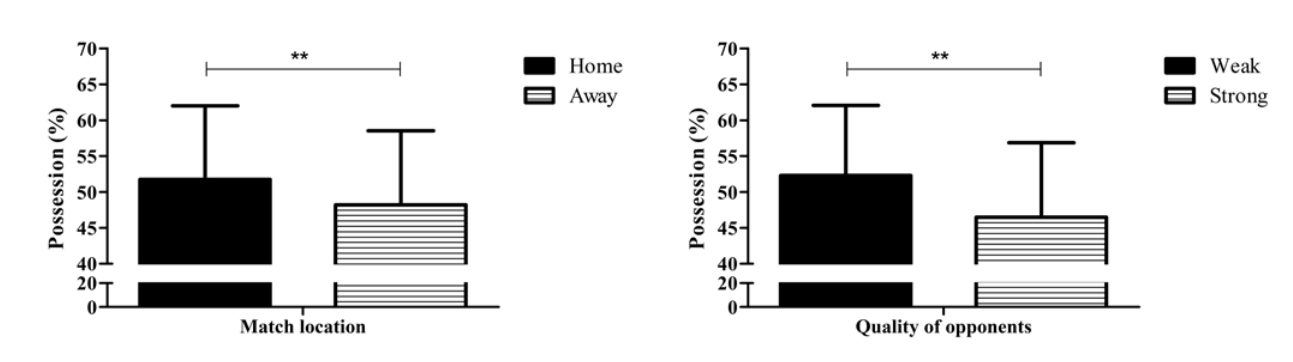
Figure 1. Influence of match location (A) and quality of opponents (B) on possession during the England Premier League season 2015/16. ** p < 0.001.